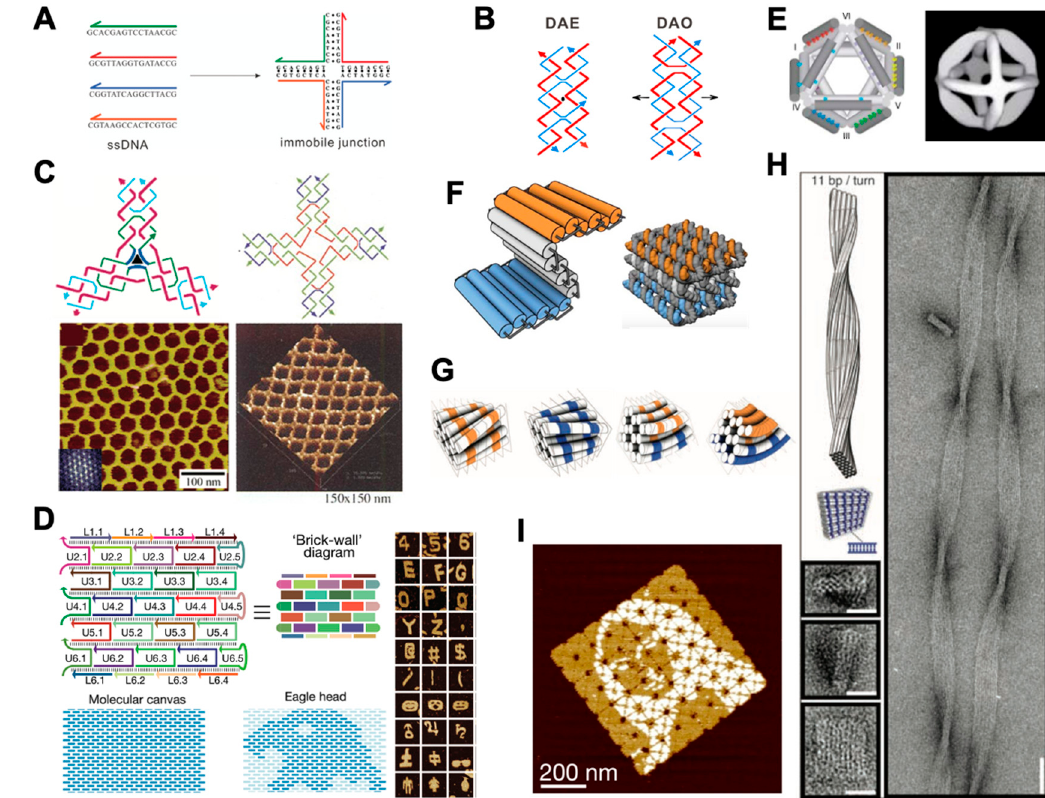
Figure 1. DNA nanostructures created by DNA tile and DNA origami assembly. ( A ) Artificial immobile junction assembled from four ssDNA strands, adapted with permission from [37] . ( B ) Double crossover structures, adapted with permission from [38] . ( C ) 2D DNA crystals made from DNA tiles with three and four arms, adapted with permission from [39,40] ( D ) DNA bricks for the assembly of 2D objects, adapted with permission from [11] . ( E ) An earlier 3D octahedron created prior to the birth of DNA origami, adapted with permission from [41] . ( F ) Cylinder model and atomistic DNA model of a honeycomb-pleated origami, adapted with permission from [27] . ( G ) Cylinder model of the twisted and curved 3D DNA origami, adapted with permission from [17] . ( H ) Models and TEM images of a twisted 10 × 6-helix DNA bundle, adapted with permission from [17] . ( I ) An 8 × 8 array of DNA origami with an example pattern of Mona Lisa, adapted with permission from [42] .